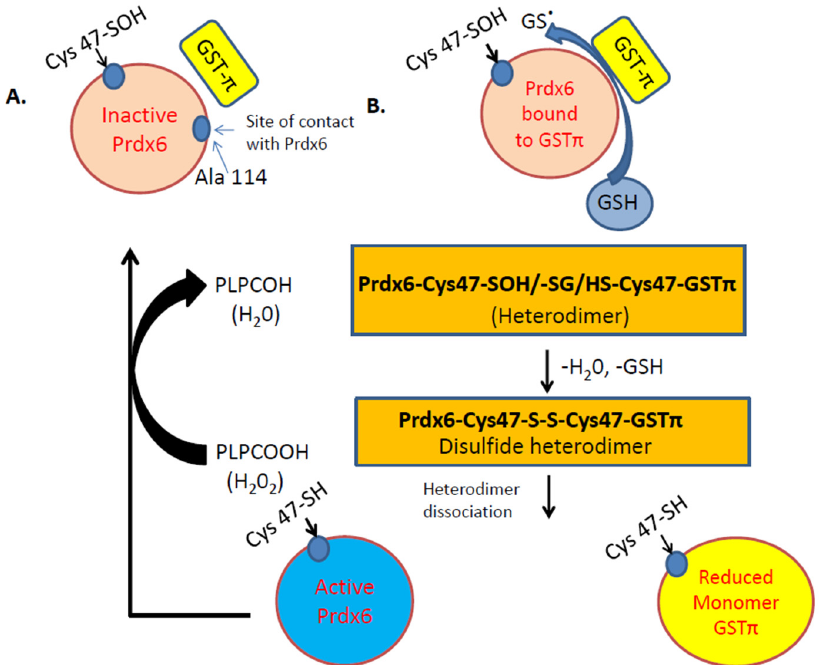
Figure 2. Illustration of the Peroxidase activity of Prdx6. A. Inactive Prdx6: its active site (Cys 47) needs to be oxidized to Cys-sulfenic acid (Cys47-SOH). B. After oxidation of Cys47 to sulfenic acid (-SOH), the Prdx6 forms a heterodimer with thiolate anion (via GST π ). S-glutathionylation of the heterodimer, followed by its alignment with the catalytic Cys47 of GST π , results in the formation of a disulfide-based heterodimer. Reduction of this disulfide bond by GSH causes heterodimer dissociation to active Prdx6 monomer. The active monomer reduces phospholipid hydroperoxide (PLPCOOH) to PLPCOH.